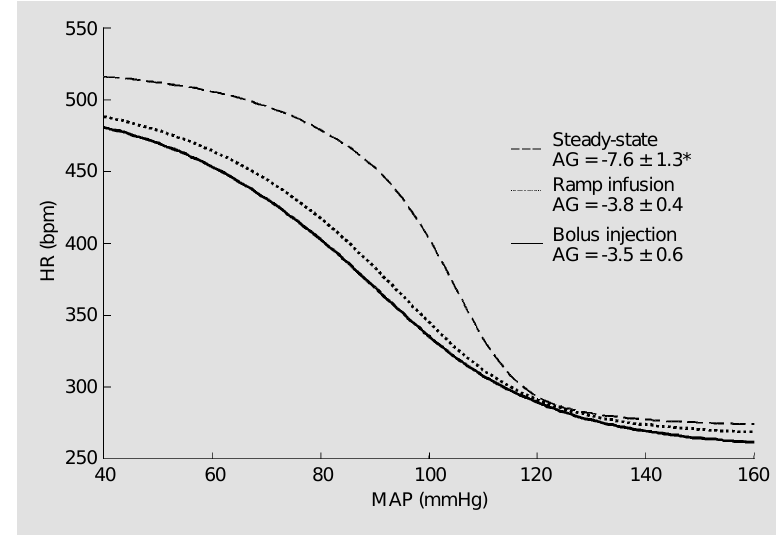
Figure 3 - Average mean arterial pressure (MAP)-heart rate (HR) baroreflex sigmoid curves obtained during blood pressure changes produced by bolus injection, steady-state and ramp infusion of vasoactive drugs. AG = Average gain (*P<0.05; two-way ANOVA-Bonferroni